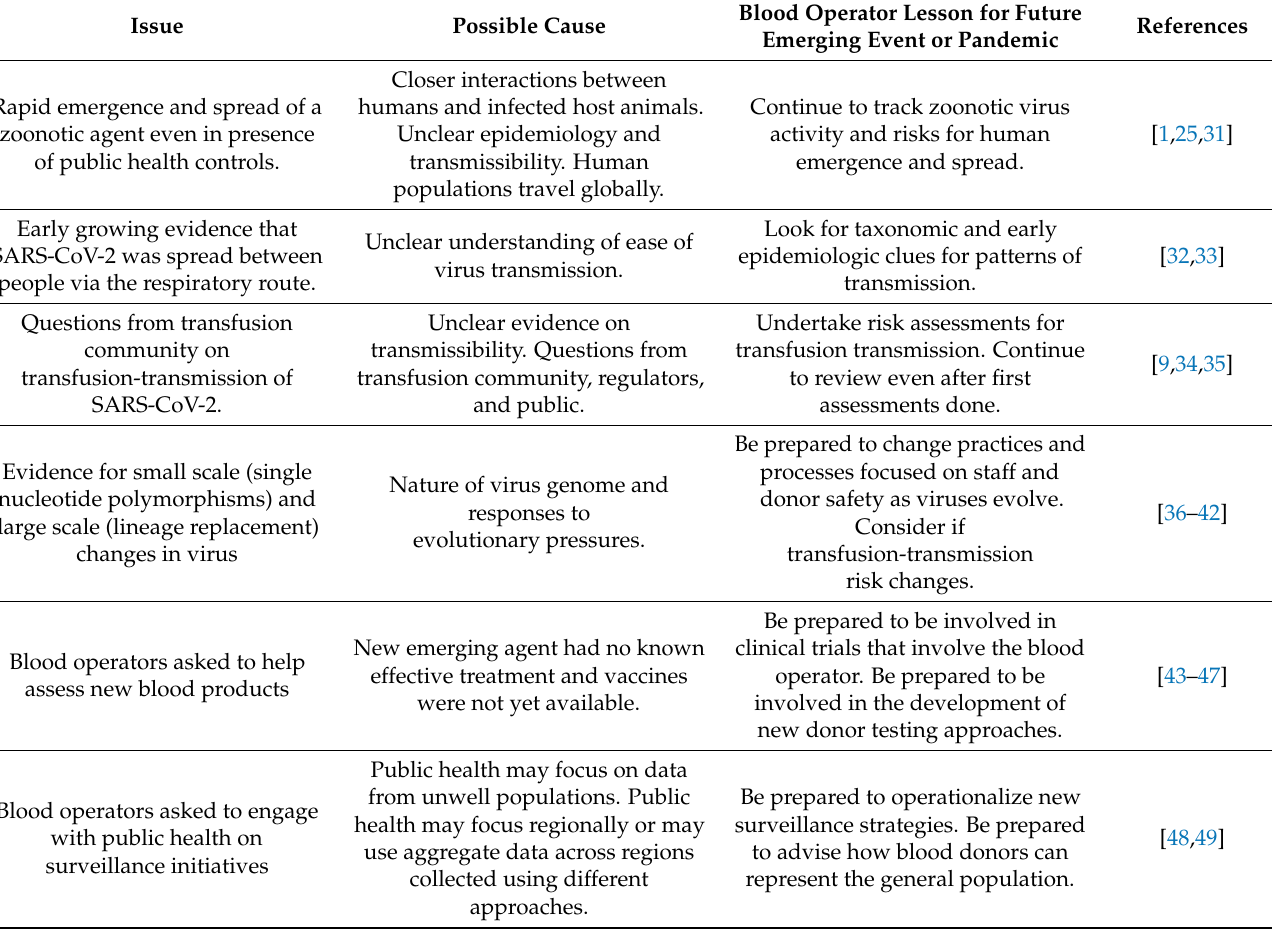
Table 1. Issues, causes and lessons learned by blood operators during the COVID-19